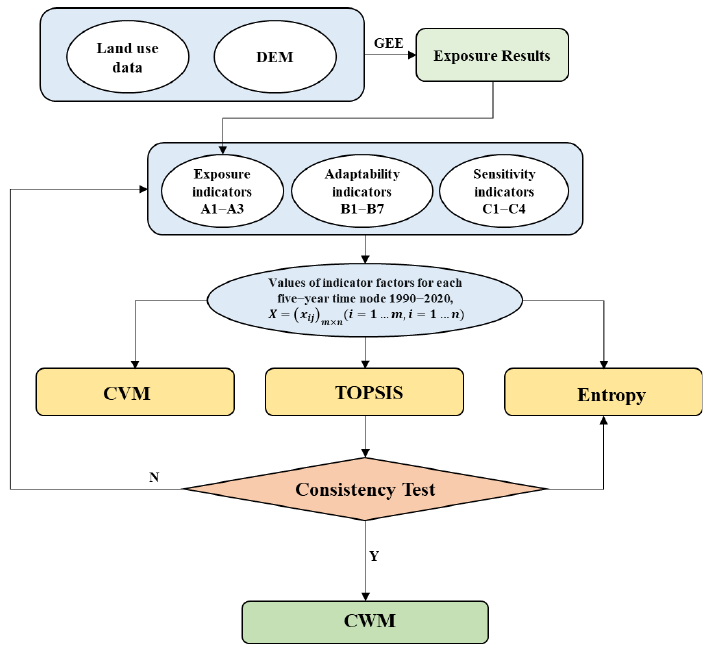
Figure 3. Flowchart of integrated vulnerability assessment methodology.